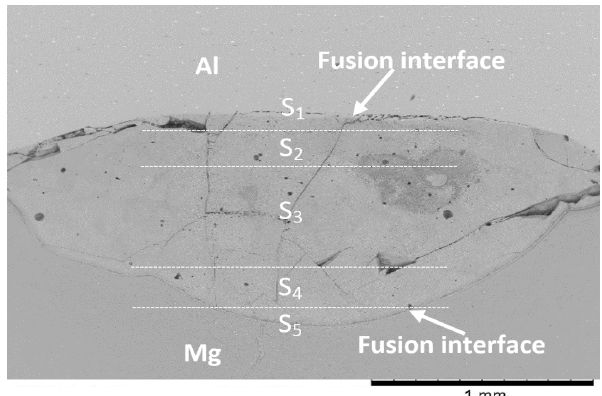
Figure 3. Al/Mg spot weld. The fusion interfaces are shown by the arrows, welding parameters: 6.3 kVA; electrode force 800 N; 300 ms. Several variations in the microstructure within the weld zone was observed, each phase was labeled S 1 to S 5.